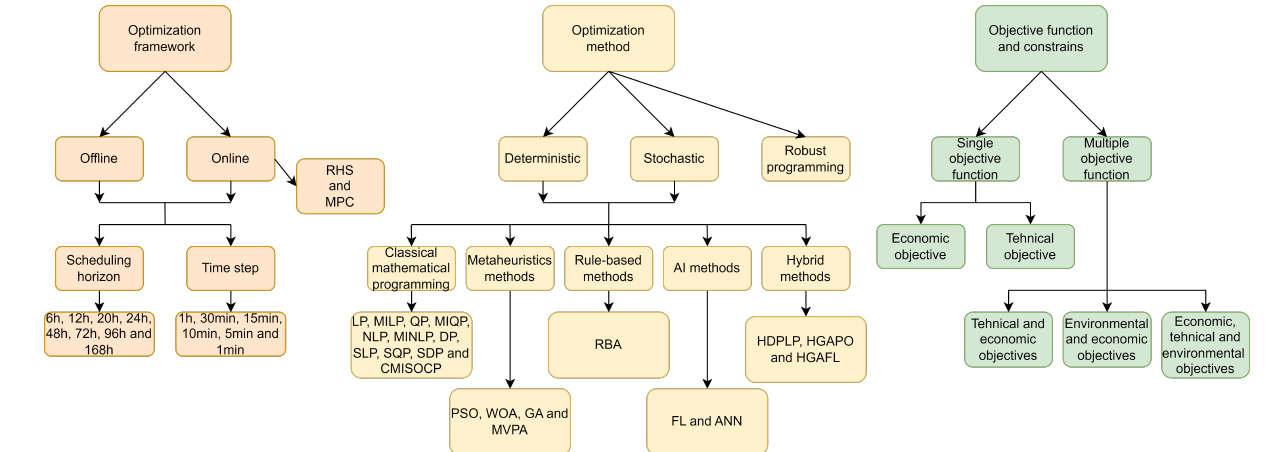
Figure 8. Overview of optimization frameworks, optimization methods, objective functions and constrains of optimization